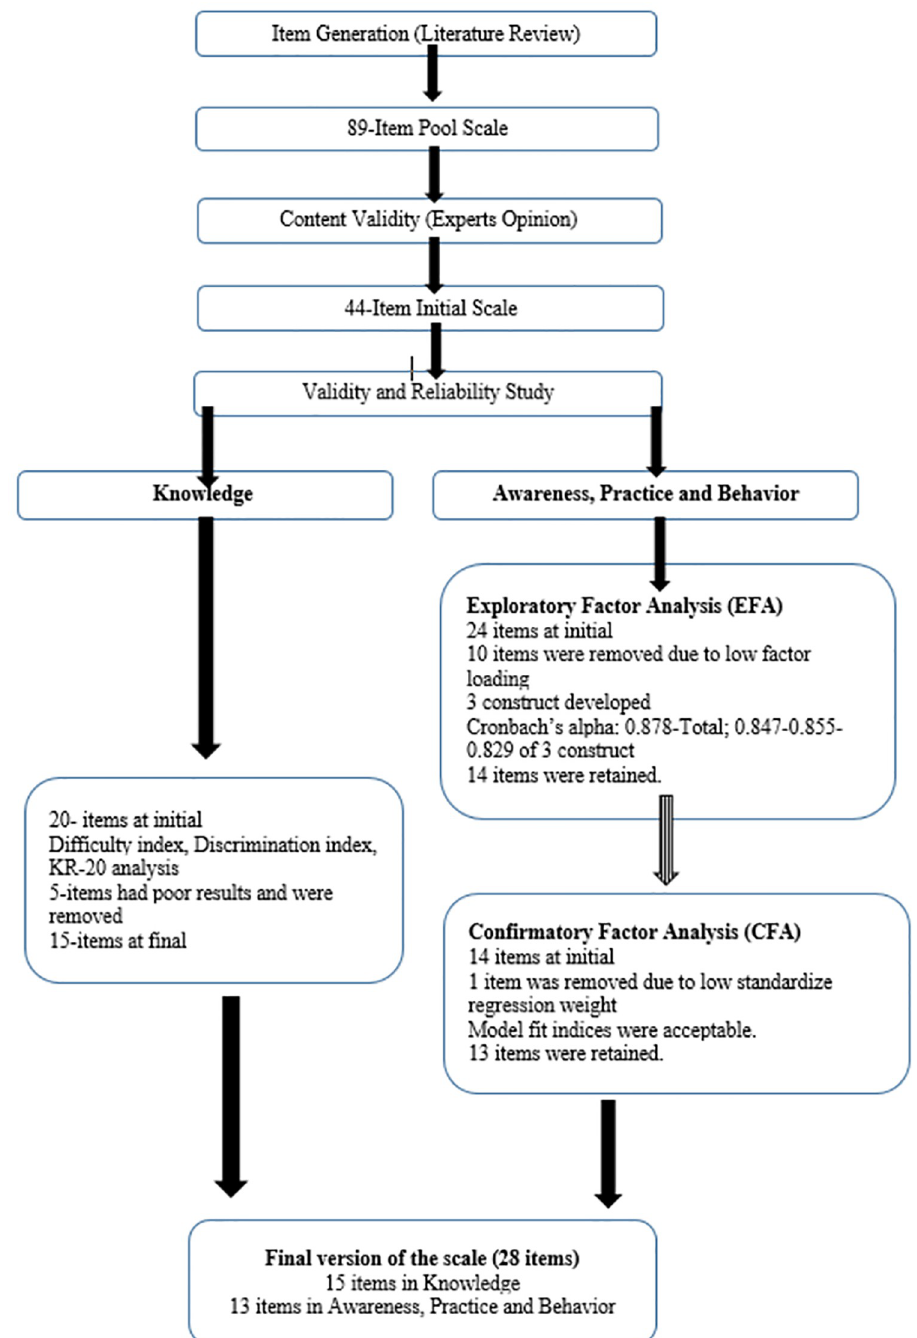
Fig 1. Flowchart of heat wave knowledge, awareness, practice and behavior scale development, validity and reliability.